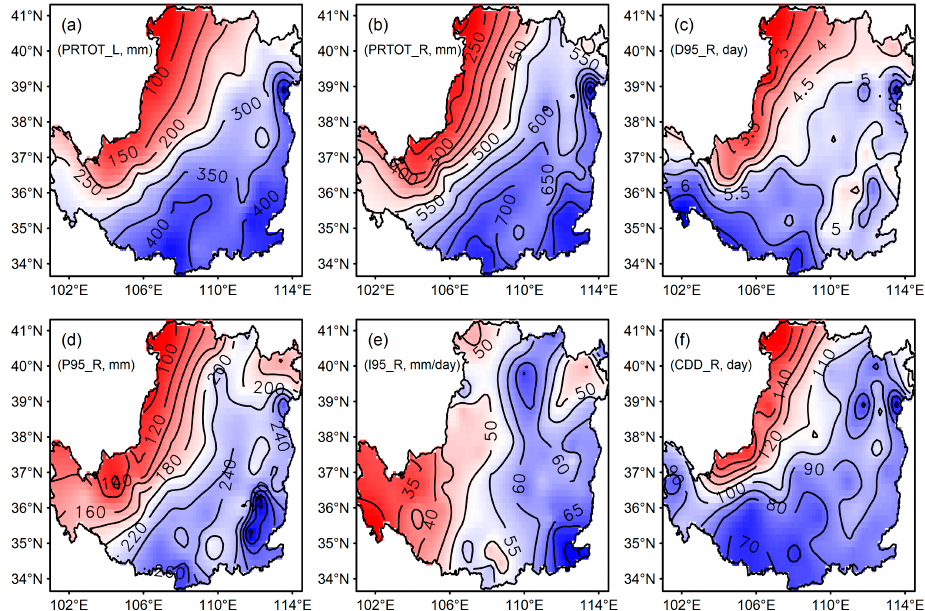
Figure 3. The values of six marked indexes at 10-year return period over the the Loess Plateau: ( a ) PRTOT_L, ( b ) PRTOT_R, ( c ) D95_R, ( d ) P95_R, ( e ) I95_R, and ( f )